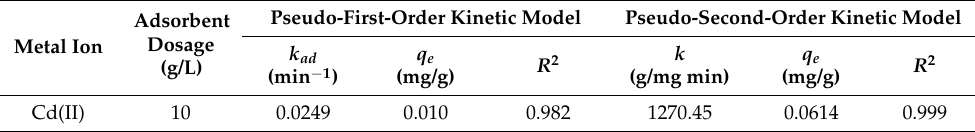
Table 3. Parameters of pseudo-first-order and the pseudo-second-order rate equations.